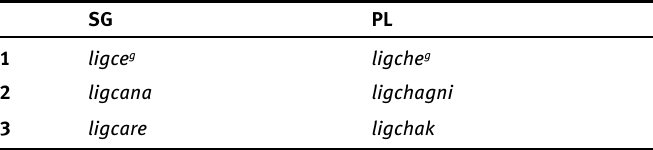
Table 5: Francke’s (1909) present tense paradigm